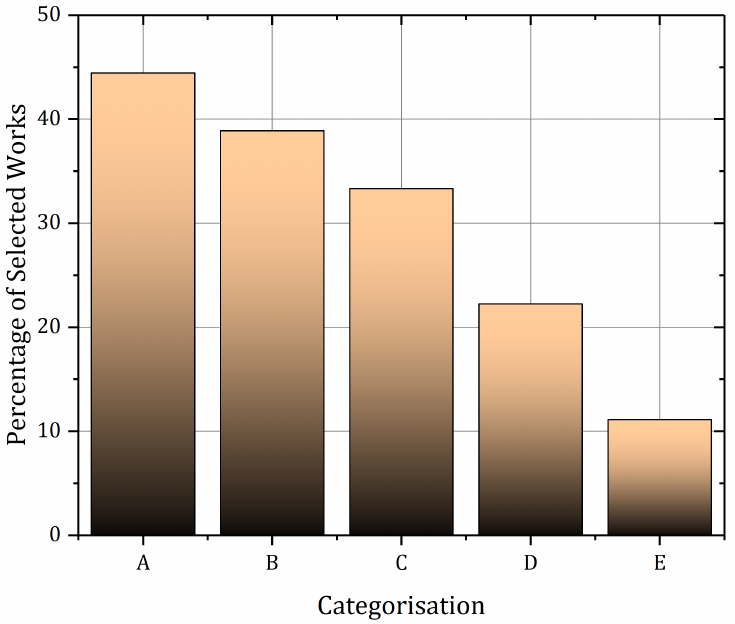
Figure 11. Percentage of Selected Works per Category defined for evaluation. A-Rehabilitation, B-Protection, C-Assistance, D-Human Robot/Computer Interaction, and E-Industry